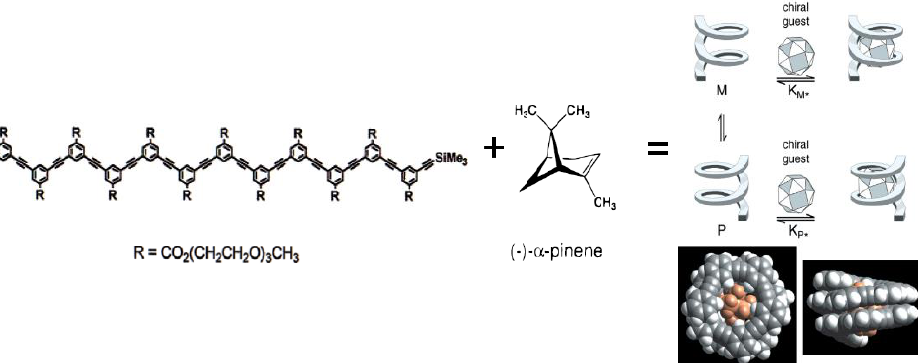
Figure 8. Association models of oligomeric phenylene ethynylene foldamer encapsulating (-)-R-pinene [32].